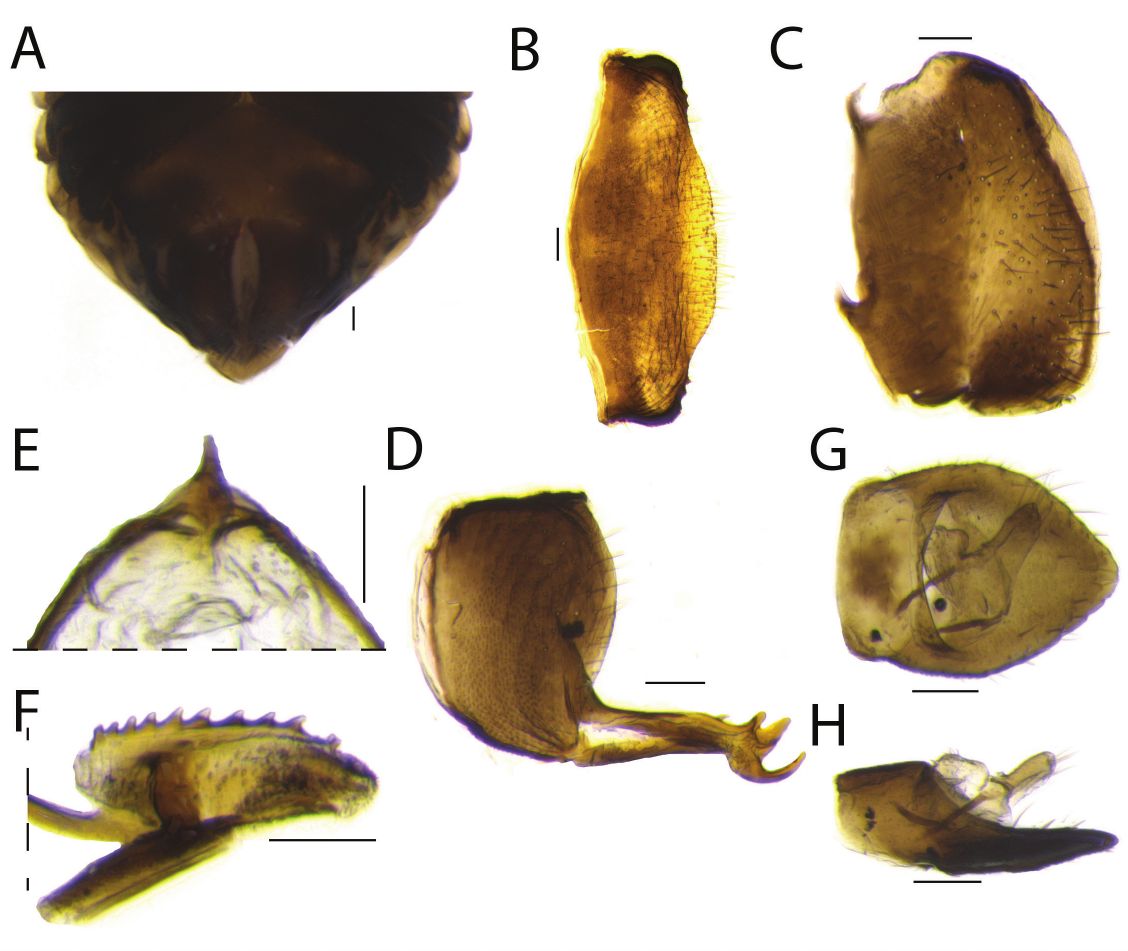
Fig. 5. Female terminalia of Bruchomorpha decorata Metcalf, 1923, ♀ (NMNH). A . External female terminalia, ventral view. B . Sternite VII, ventral view. C . Gonoplac, lateral view. D . Anterior connective lamina of gonapophysis VIII, ventral view. E–F . Posterior connective lamina of gonapophysis IX. E . Connective part in dorsal view. F . Distal part in lateral view. G–H . Anal tube. G . Dorsal view. H . Lateral view. Scale bars = 0.1